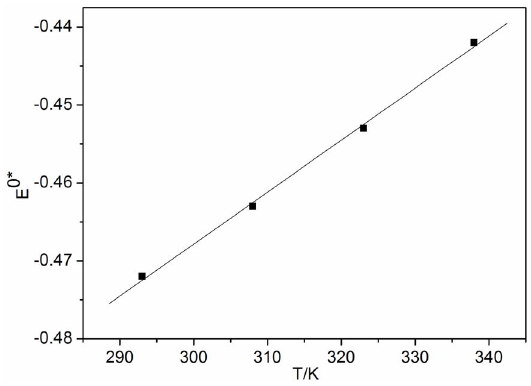
Figure 6. Plots of E 0 * Eu(III)/Eu(II) against T .